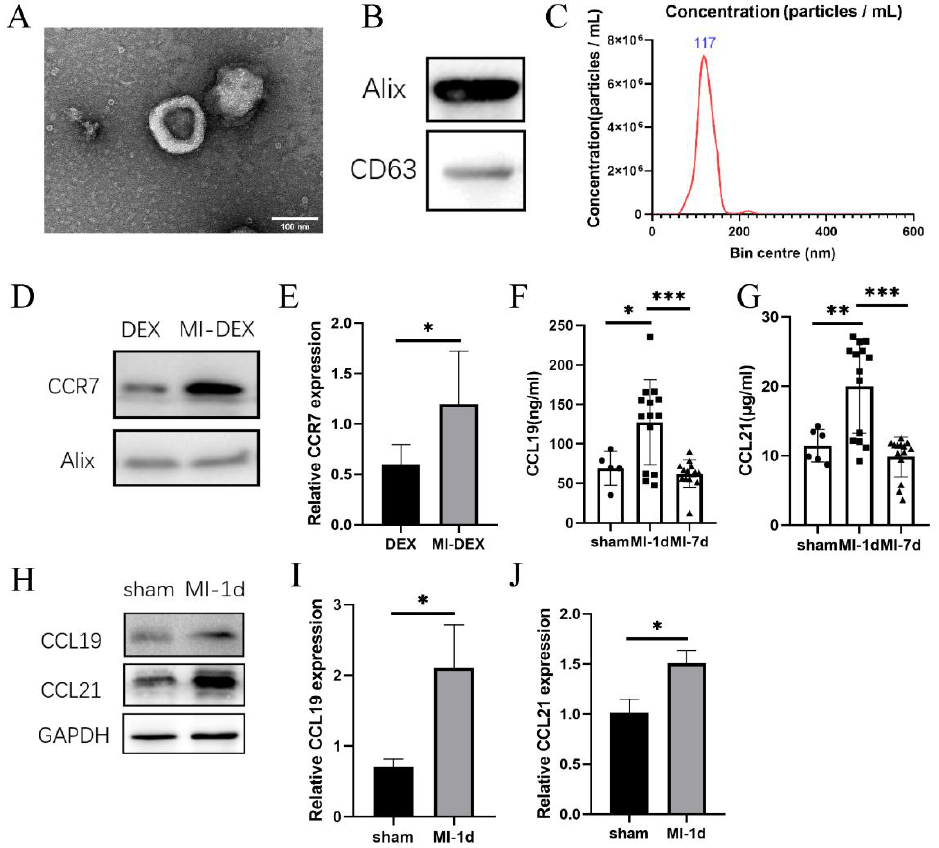
Figure 1. Characterization of MI-DEXs. Sample of MI-DEXs examined by transmission electron mi- croscopy (TEM) image (A). CD63 and ALIX in MI-DEXs analyzed by Western blot analysis (B). The particle size distributions of MI-DEXs were analyzed by nanoparticle tracking, and the mode diam- eter was 117 nm (C). Expression of CCR7 in DEXs and MI-DEXs (D – E). n = 3 – 8. ELISA analysis of CCL19 and CCL21 in serum after MI (F-G). n = 5 – 15. Expression of CCL19 and CCL21 in the spleen after MI (H – J). n = 3 – 8, * p < 0.05, ** p < 0.01, *** p <